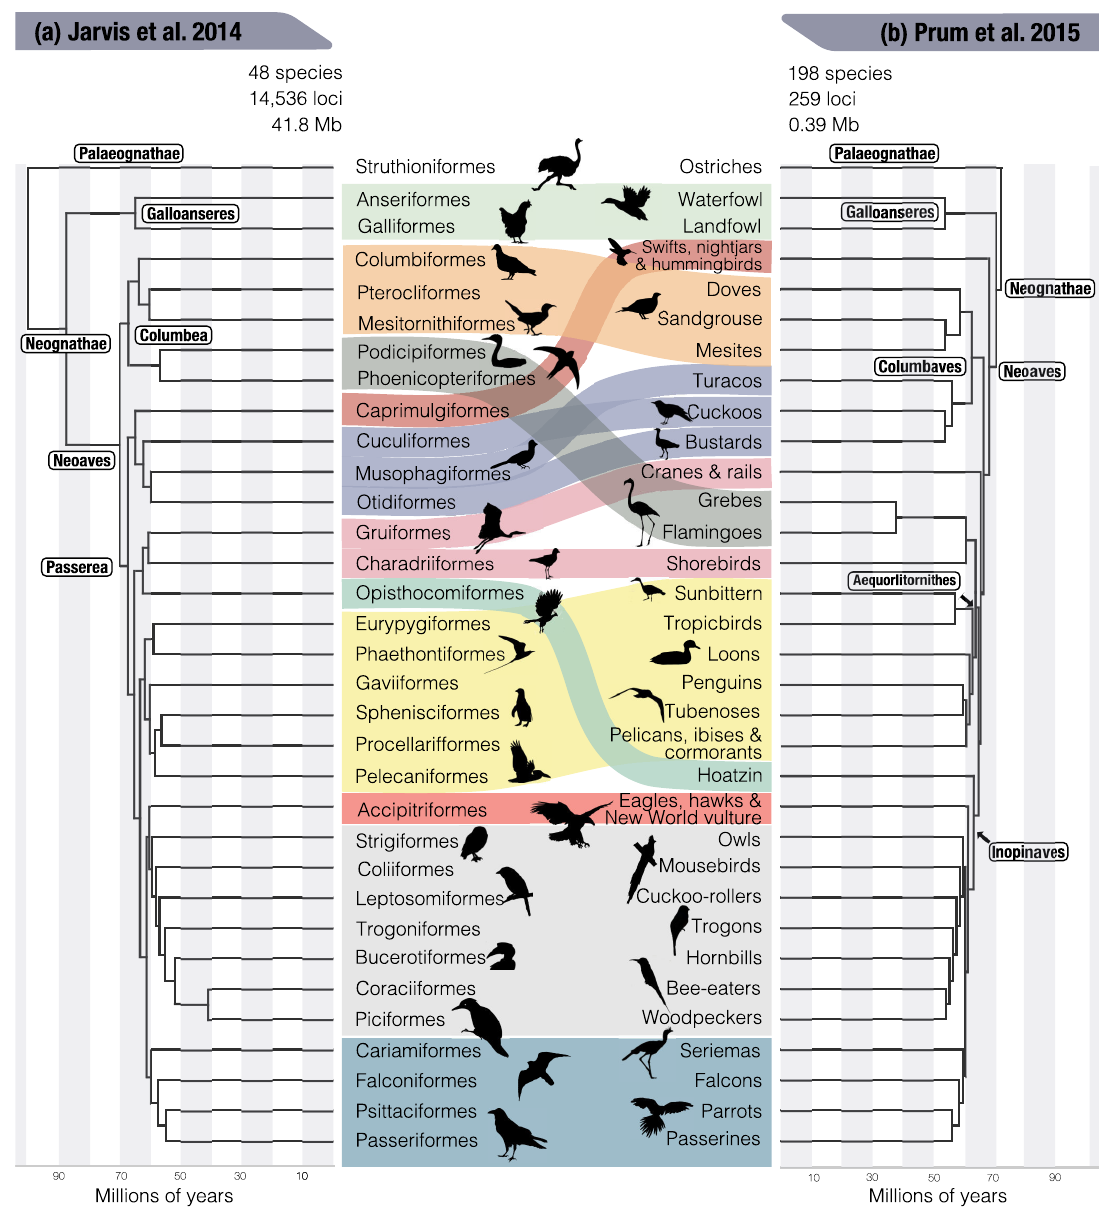
Figure 2. Overview of the main competing hypotheses based on two studies with different strengths in their data acquisition: ( a ) Sequence-focused analysis of Jarvis et al. [10] based on whole genome sequence data for 48 birds analyzing 8251 protein-coding loci, 2516 introns, and 3679 ultraconserved elements; ( b ) Taxon-sampling-focused analysis by Prum et al. [42] with 198 species but only 0.4 Mb of conserved coding sequence data. The two hypotheses are difficult to reconcile because of differences in the extent of genomic and taxonomic sampling, the type of loci, and the method of analysis. Clades that are discussed in the text are annotated, for the complete systematic classification the reader is referred to the original